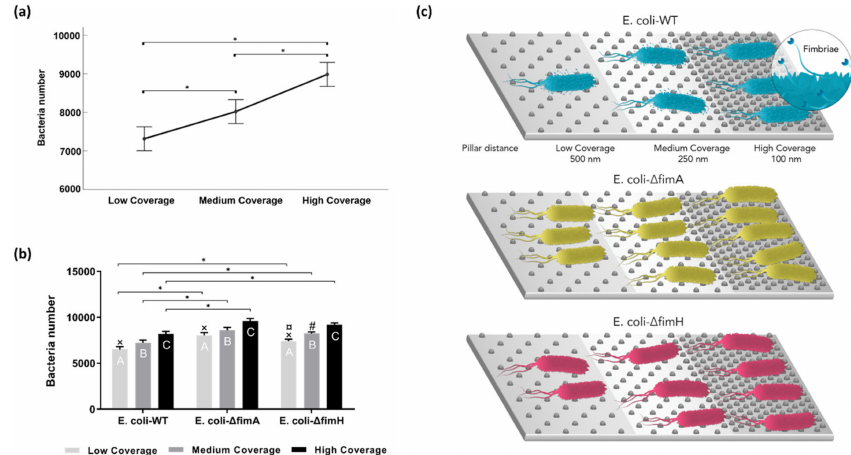
Figure 4. Bacteria adhesion to di ff erent surface coverages: ( a ) Bacteria number (calculated marginal means) for all tested strains. Significant at * p -value < 0.05. Median values with error bars represent the 95% confidence interval ( n = 191, * p < 0.05); ( b ) average bacteria number to di ff erent surface coverages with the standard error of the mean. Comparison within tested strains (significant at p -value < 0.05, n = 191): × low coverage vs. medium coverage, # low coverage vs. high coverage, ¤ medium coverage vs. high coverage; ( c ) graphical presentation of tested strains attaching to di ff erent surface